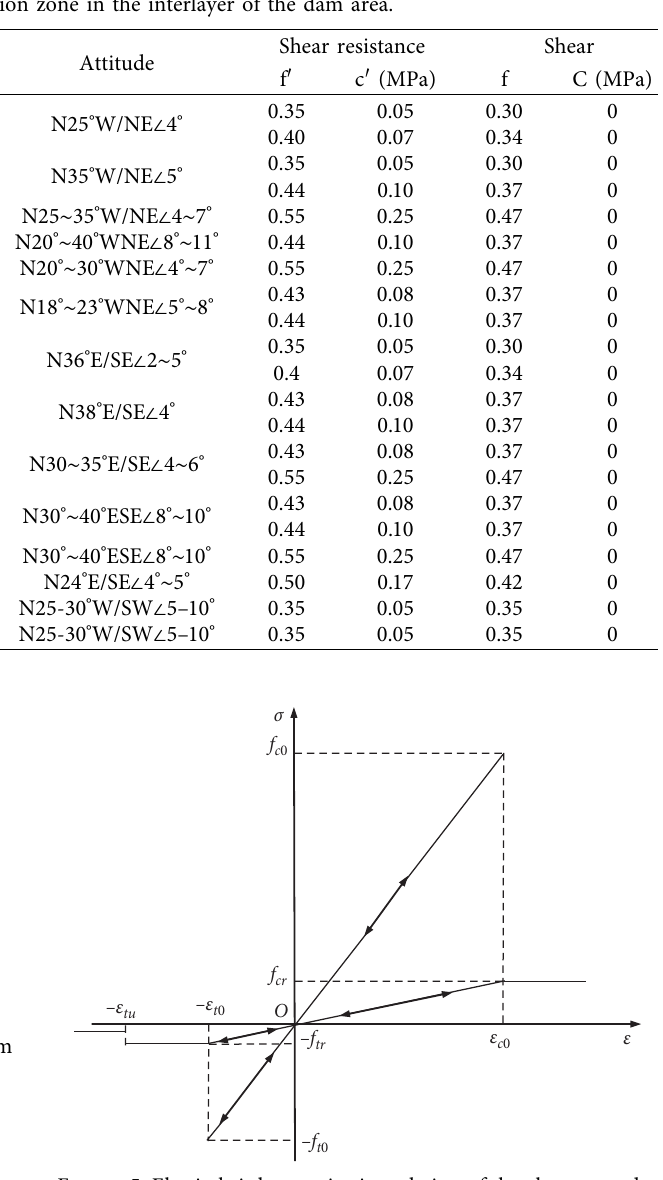
Figure 5: Elastic-brittle constitutive relation of the element under uniaxial stress